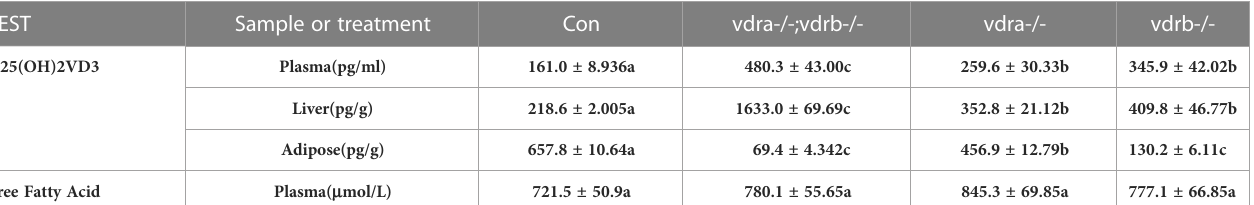
TABLE 2 The levels of 1 a ,25(OH) 2 VD 3 and free fatty